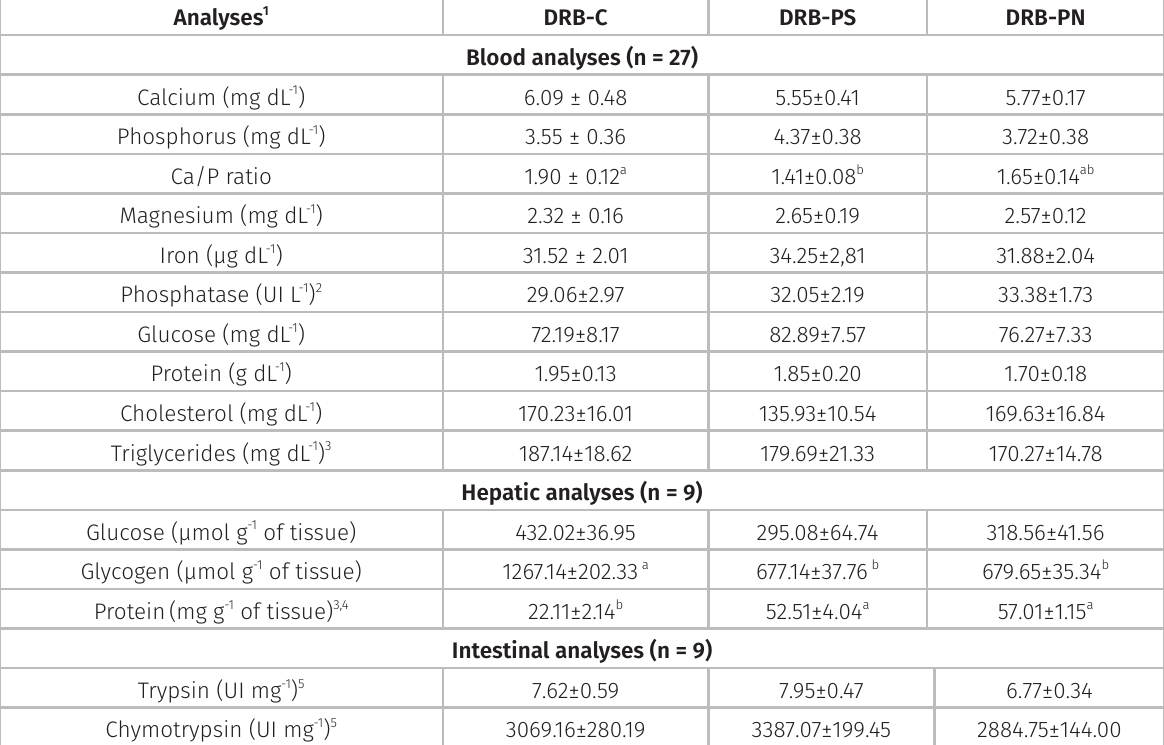
Table III. Biochemical parameters of juvenile grass carp ( Ctenopharyngodon idella ) fed on diets with different phytase sources.